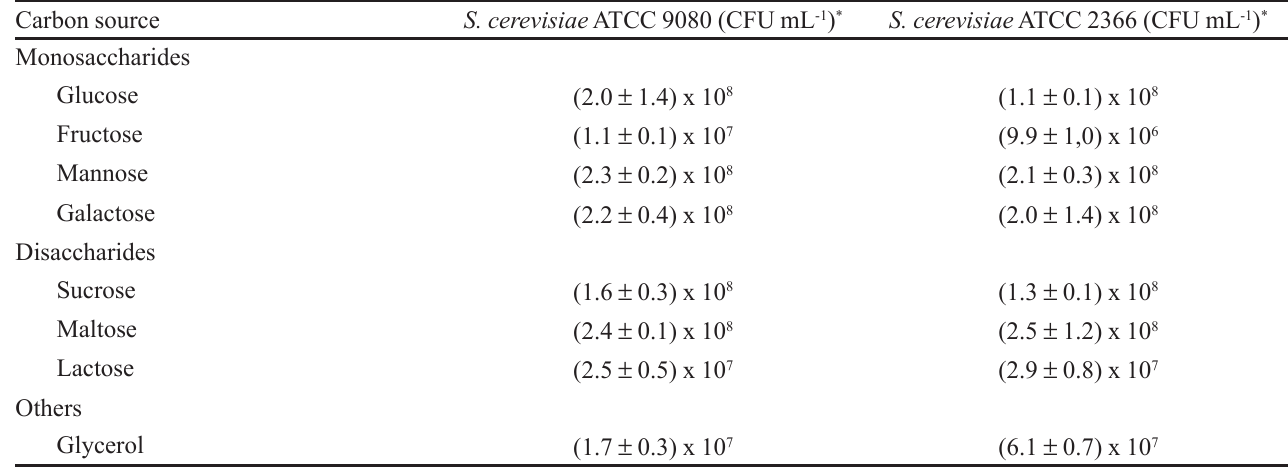
FIGURE 1 - Growth curves of S. cerevisiae strains ATCC 9080 (A) and ATCC 2366 (B) grown in different carbon sources, at concentrations of 2 % (w/v). TABLE I - Maximum cell growth of S. cerevisiae at end of exponential growth